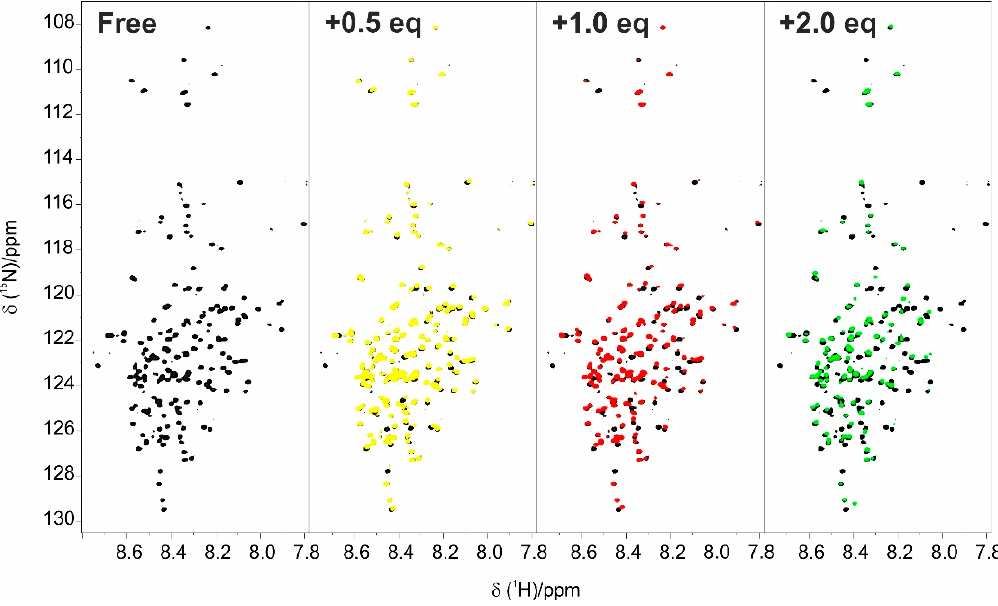
Figure 3. Titration of E1A12S with CBP-ID4 followed by 1 H- 15 N BEST-TROSY experiments. E1A12S (black) E1A12S:CBP-ID4 at 1:0.5 molar ratio (yellow); E1A12S:CBP-ID4 at 1:1 molar ratio (red); and E1A12S:CBP-ID4 at 1:2 molar ratio (green). All the experiments were acquired at 283 K, using a 22.3 T Bruker Avance III NMR spectrometer equipped with a TCI CryoProbe TM .